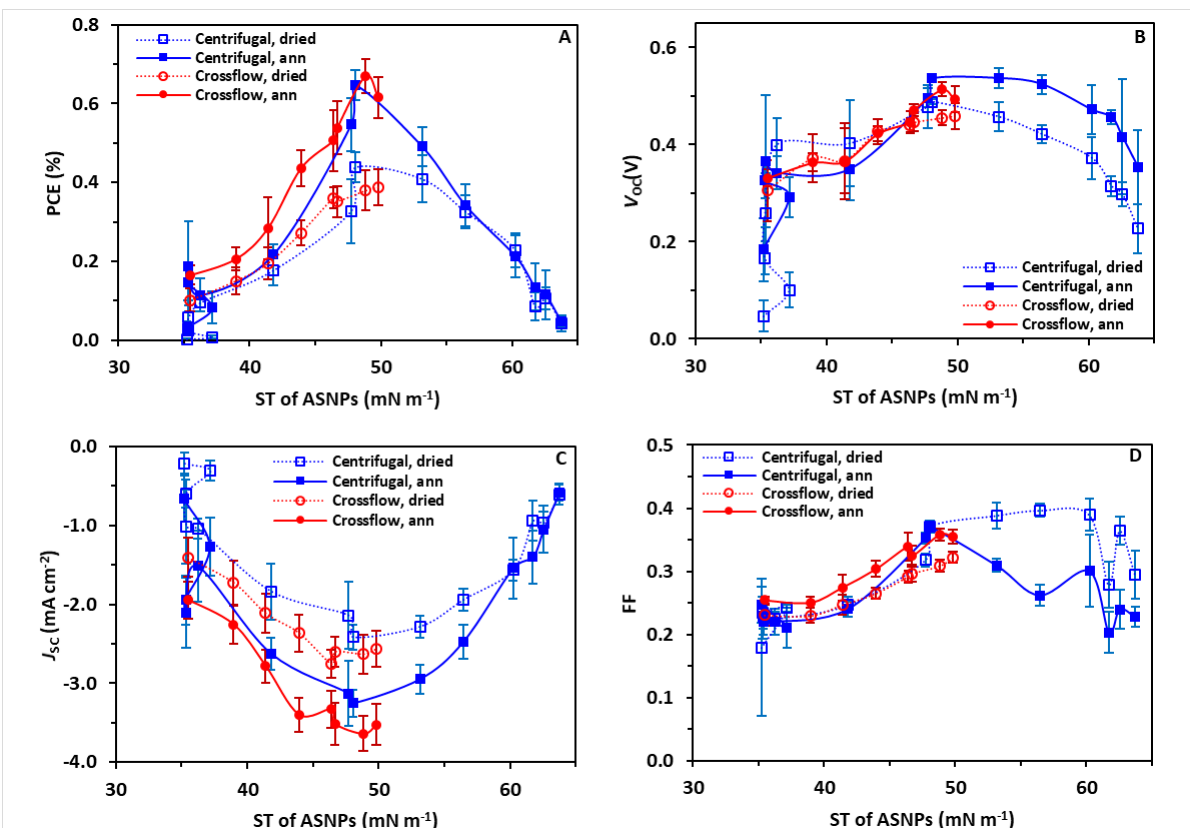
Figure 6: OPV performance showing (A) PCE, (B) V oc , (C) J sc and (D) FF values of NP-OPVs versus surface tension (ST) of P3HT:ICxA NPs dial- ysed by crossflow and centrifugal process (A–D), respectively. Solid line refers to annealed devices, and dot line refer to dried